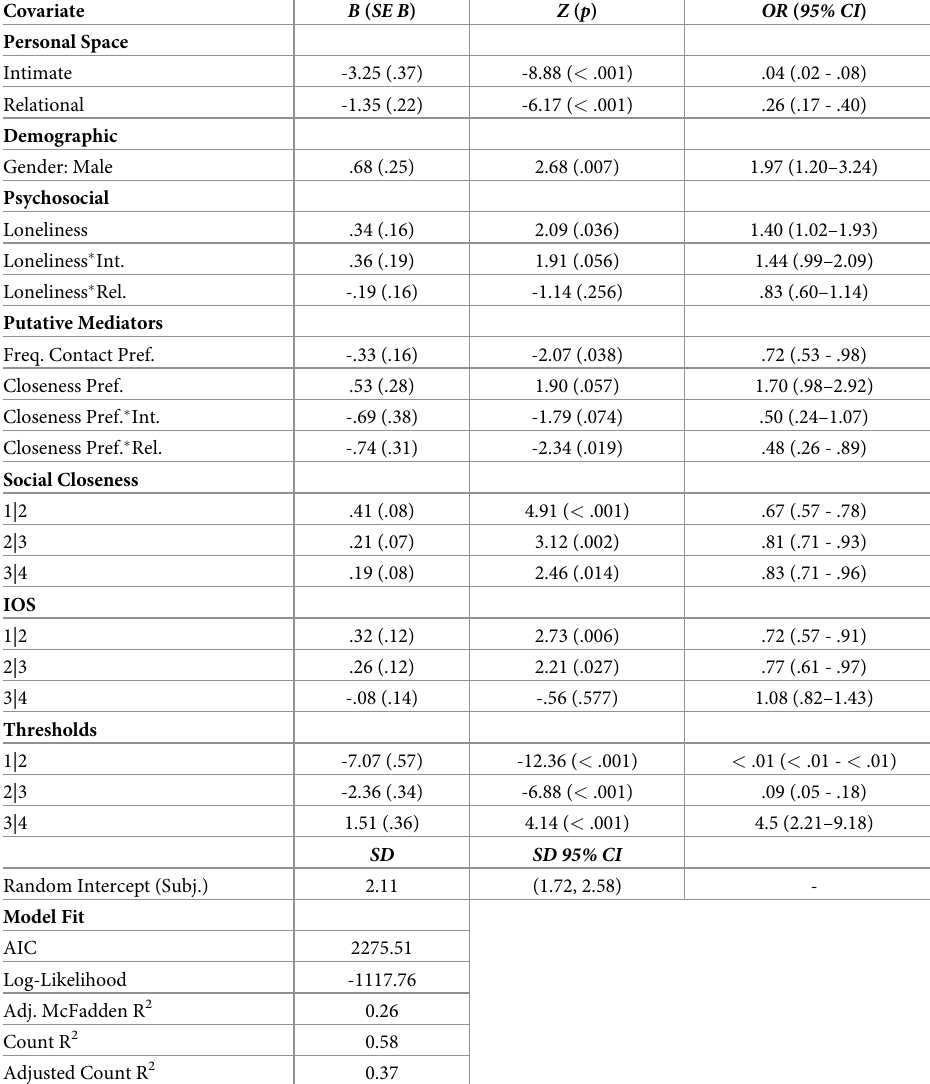
Table 4. Regression results for Study 2 putative mediator